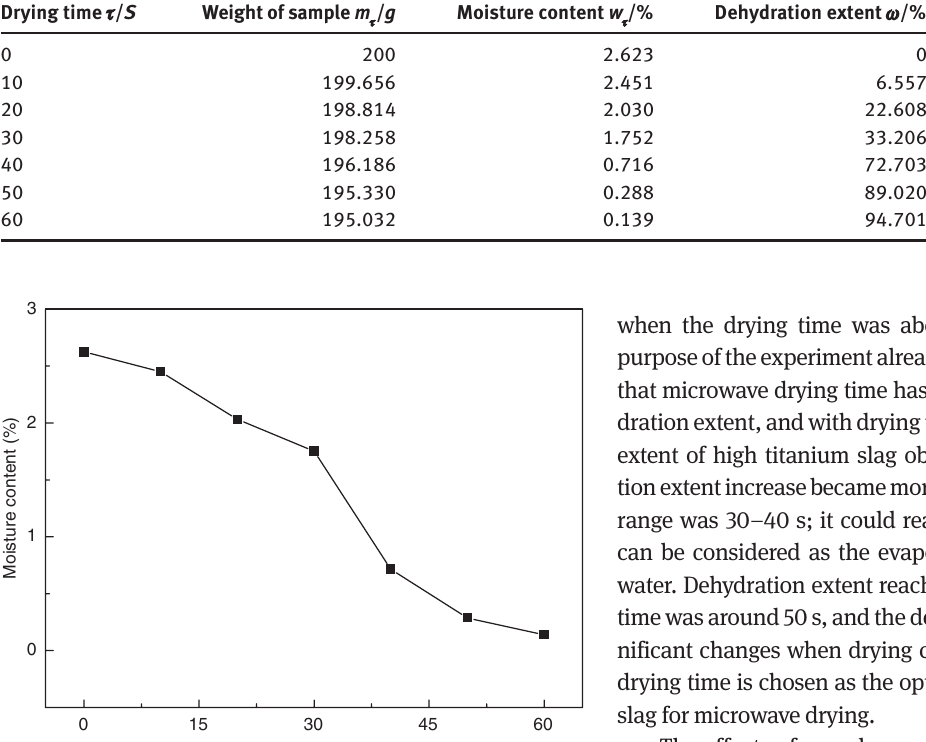
Table 3: The related data of drying high titanium slag under microwave heating. Drying time τ / S